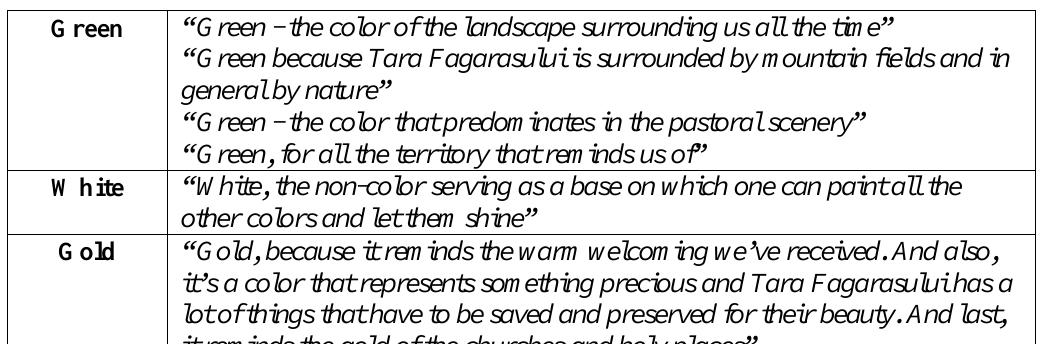
Table 2: Associations made by Italian Participants describing theirs Visual Experience